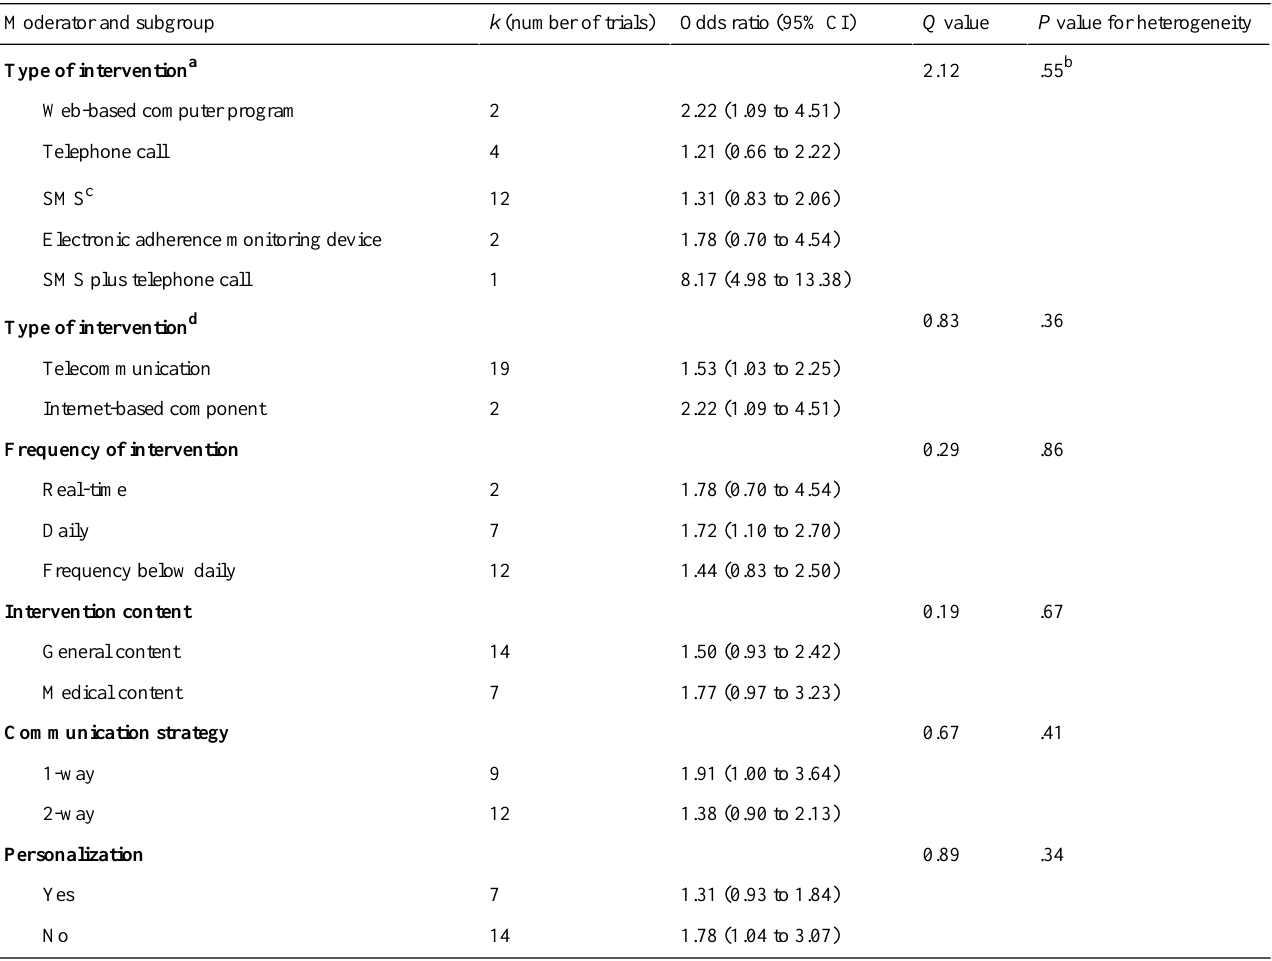
Table 3. Subgroup analyses of the effect of electronic health on antiretroviral therapy adherence by intervention